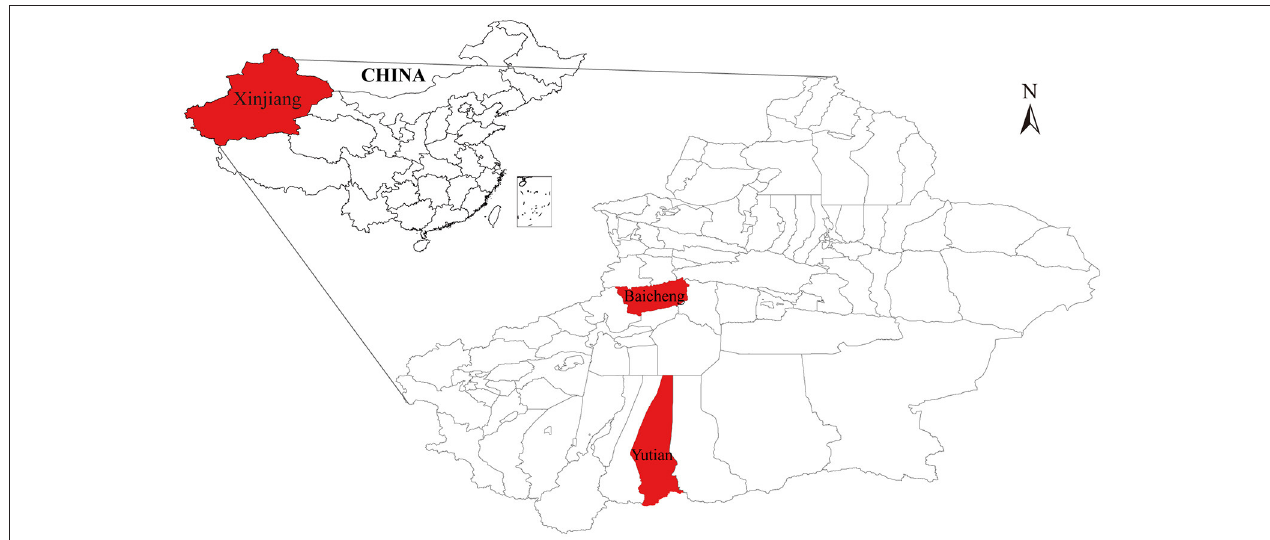
FIGURE 1 | A simplified map of Xinjiang (Northwest China) where the Chinese Visna/Maedi virus strains were isolated. The geographical location of the strains isolated in the study are marked in